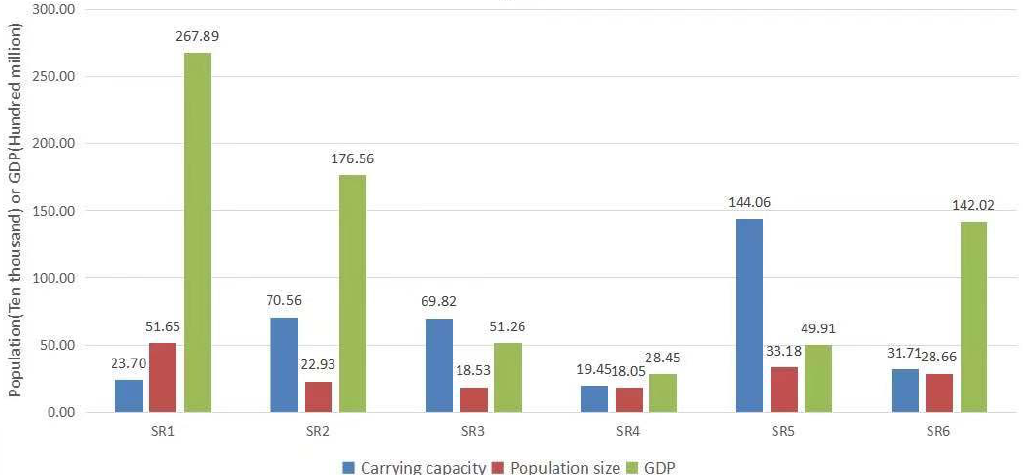
Figure 5. Population carrying capacity under the constraint of ecological land use for each sub-region in Daye City.